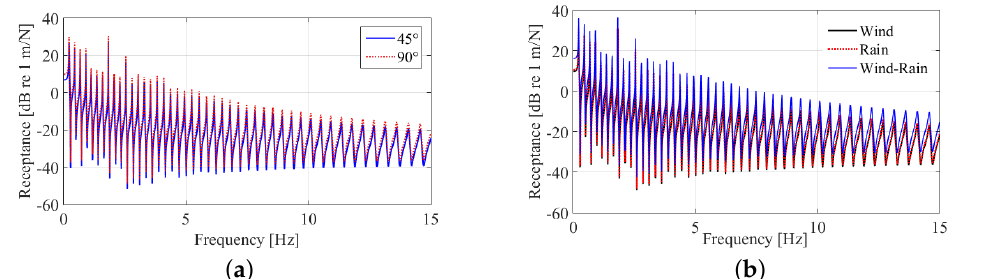
Figure 12. Comparison between FRFs estimated under wind-rain load excitation acting at 45 ◦ and 90 ◦ ( a ). Comparison among FRFs estimated under wind, rain, and wind-rain load excitation orientated at 90 ◦ ( b